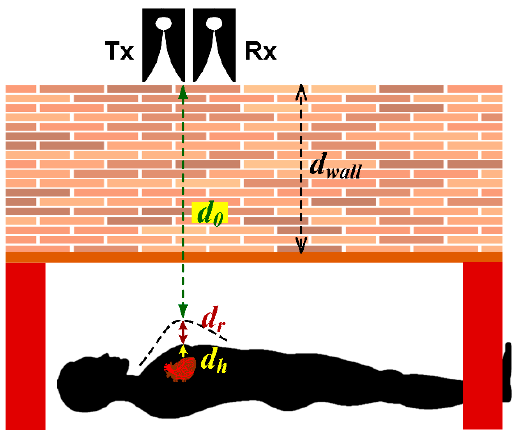
Figure 8. The distance between antenna and human subject as a function of the movement amplitudes of the heart and respiration.